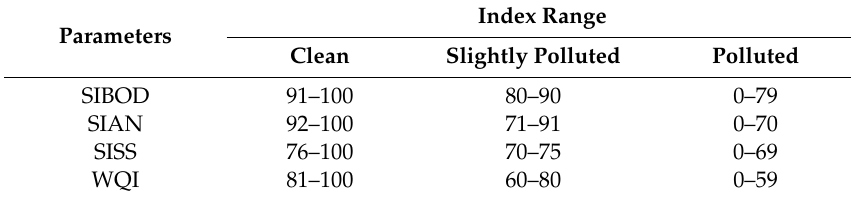
Table 5. DOE water quality classification based on Water Quality Index.